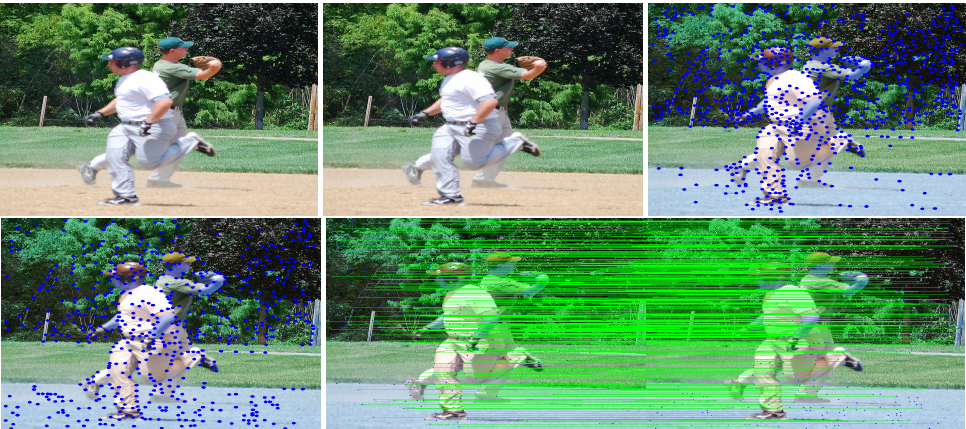
Figure 16. ( JPEG ) Row 1: Left (original image), Middle (attacked images.), Right (resulting point of original image by SuperPoint’s detector). Row 2: Left (resulting point of attacked image by SuperPoint’s detector), Right (the green lines show the correct correspondences after blurring